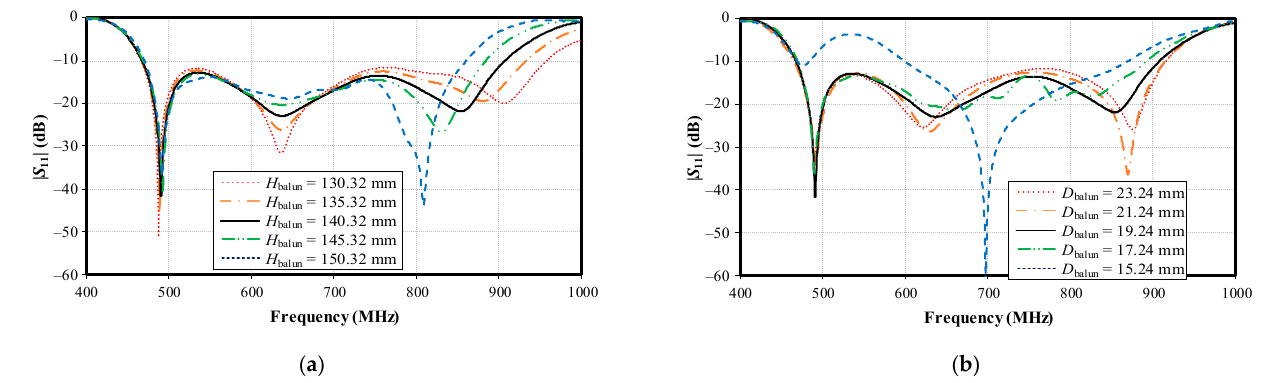
Figure 15. Simulated impedance bandwidth (| S 11 | ≤ − 10 dB) under variable parameters: ( a ) balun height ( H balun ), ( b ) distance from center to center of the balun ( D balun ).